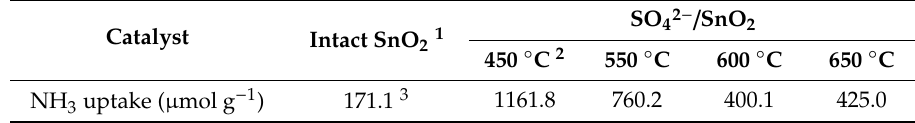
Table 1. NH 3 uptake of intact SnO 2 and SO 42 − / SnO 2 calcined at di ff erent